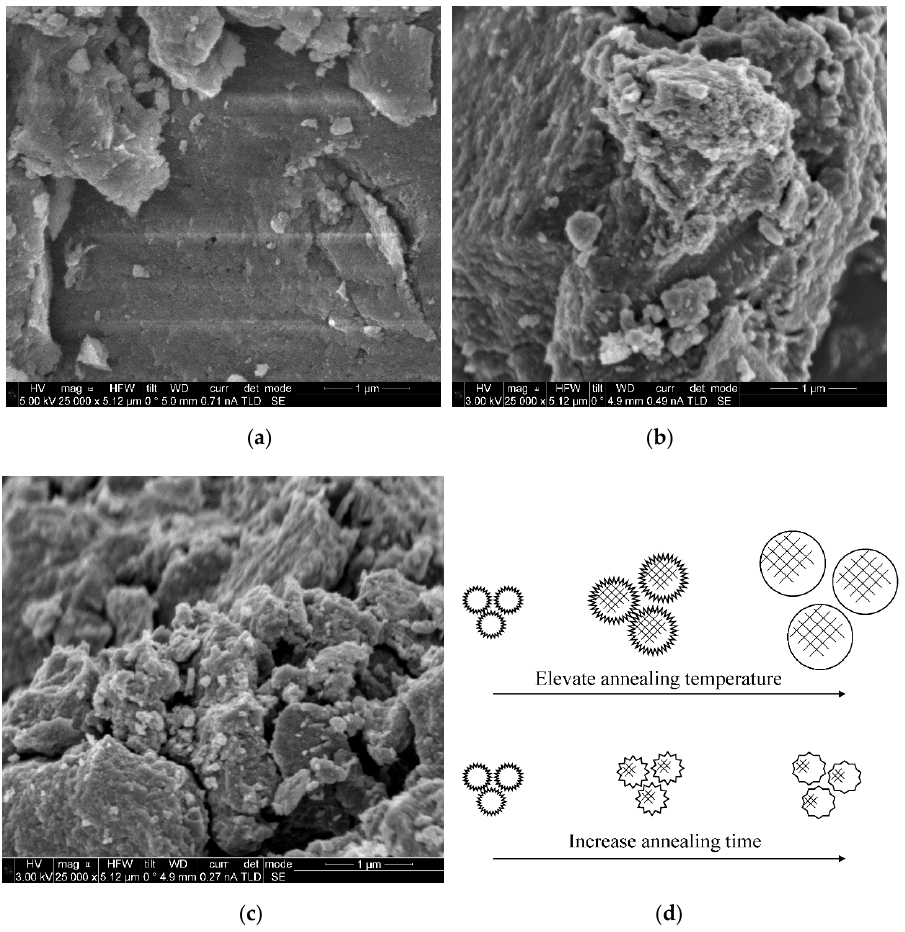
Figure 5. ( a – c ) SEM image of N-doped TiO 2 annealed for 1 h under 300 °C, 400 °C, and 500 °C respectively. ( d ) Schematic illustration of the effect of annealing temperature and time on the size and morphology of N-TiO 2 .